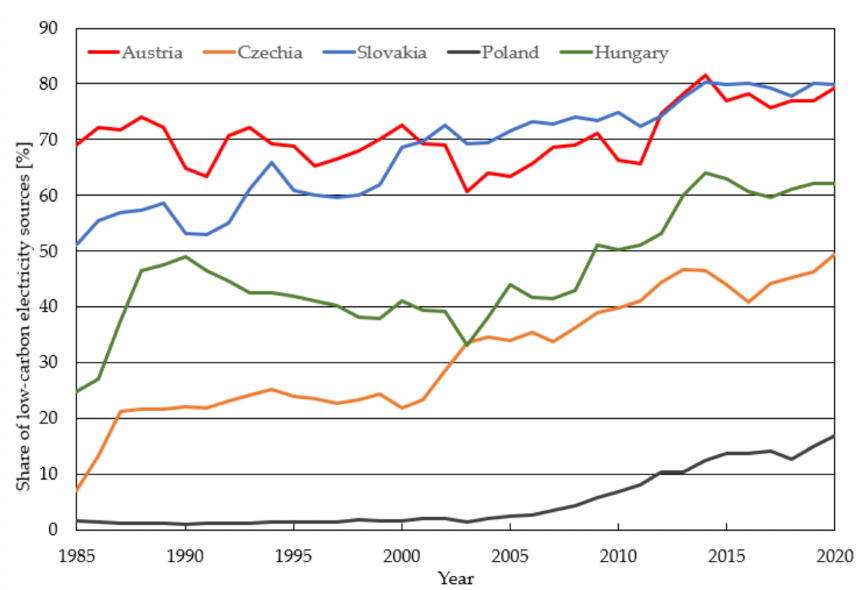
Figure 15. Share of low-emission sources in electricity production (1965–2019) [49]. Unsurprisingly, the biggest polluter in terms of CO 2 emissions is Poland, which emitted 322 million tons of carbon dioxide into the atmosphere in 2019. It is followed by the Czech Republic with more than 100 million tons, Austria 68 million tons,